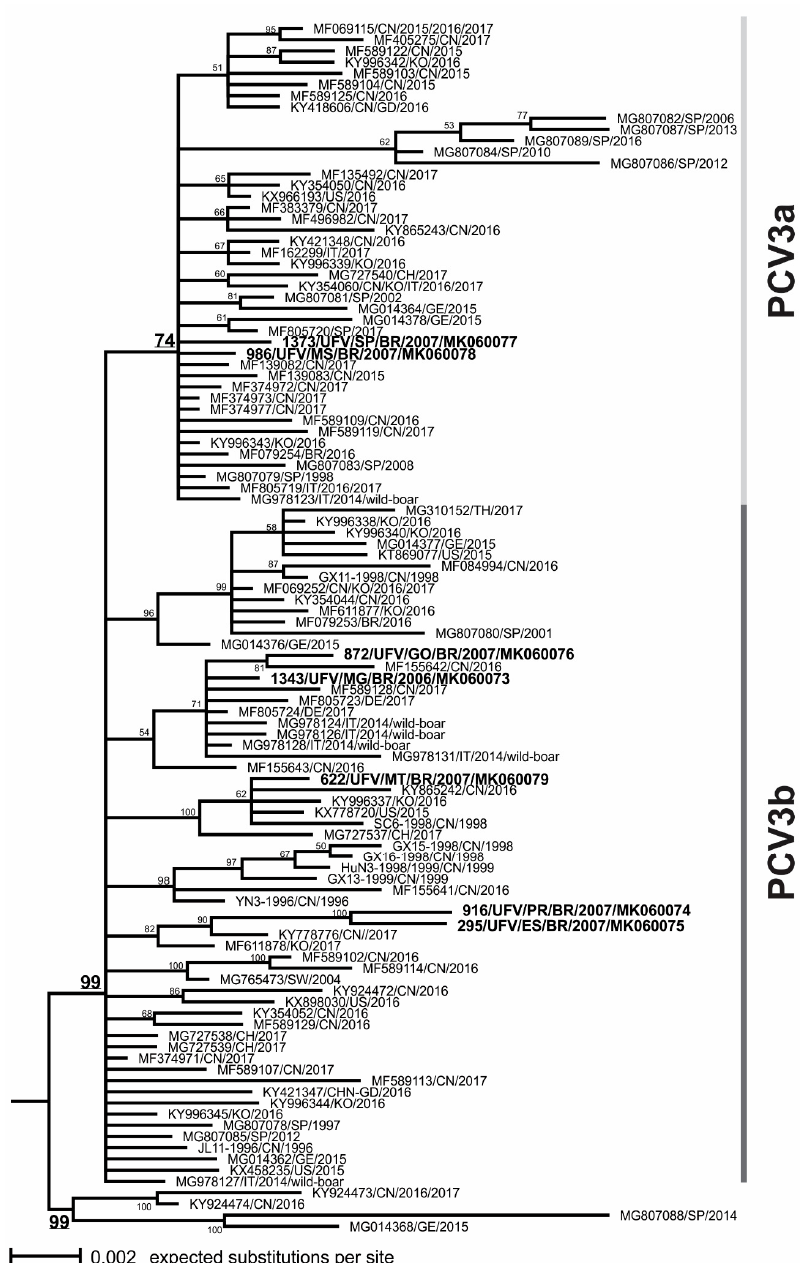
Figure 2. Phylogenetic clustering of PCV3 strains. The midpoint rooted majority-rule consensus tree was obtained by Bayesian Inference (BI) analysis of 108 ORF2 nucleotide sequences. The scale bar indicates nucleotide substitutions per site. The posterior probability values (expressed as percentages) are shown beside each node. The sequences obtained in this study are highlighted in